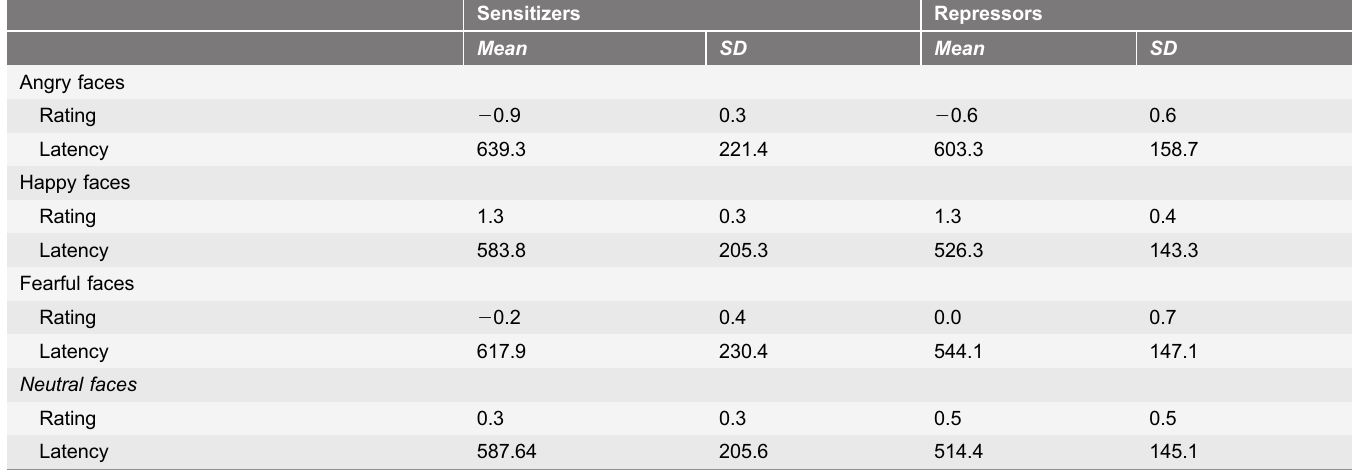
Table 2. Face evaluation task (fMRI experiment): evaluative ratings and latencies as a function of facial expression and coping style (low values indicate more perceived